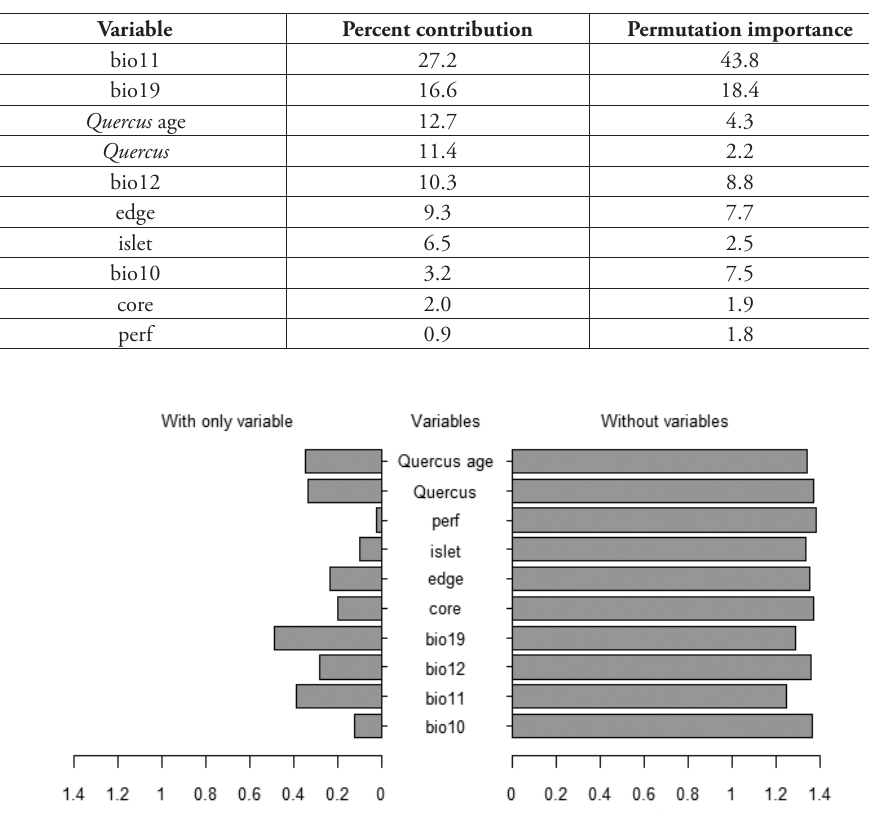
Figure 5. Results of jackknife test of variable importance using training gain. Values shown are averages over 50 replicate runs for each predictor variable alone (left) and the drop in training gain when the vari- ables are removed from the full model (right). Explanation of variable codes: see Table 1.